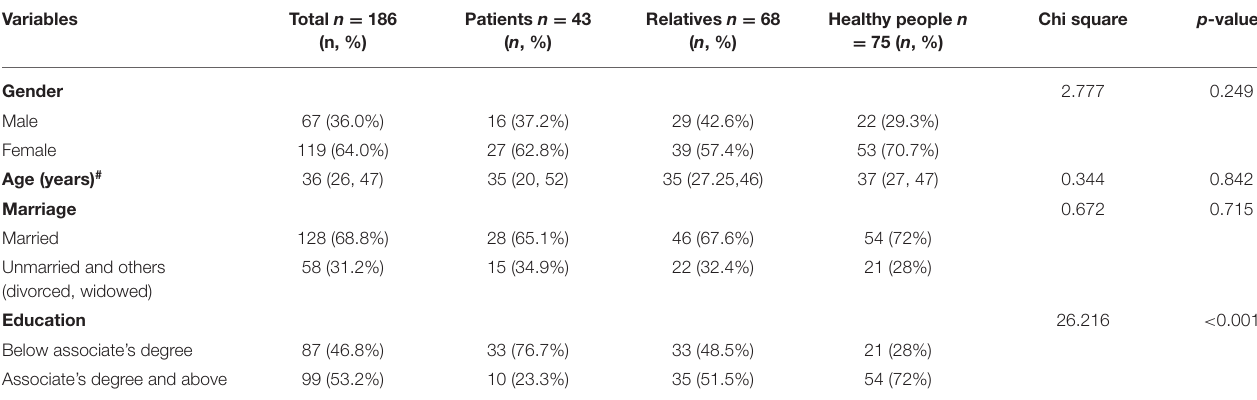
TABLE 1 | Demographic characteristics of participants.